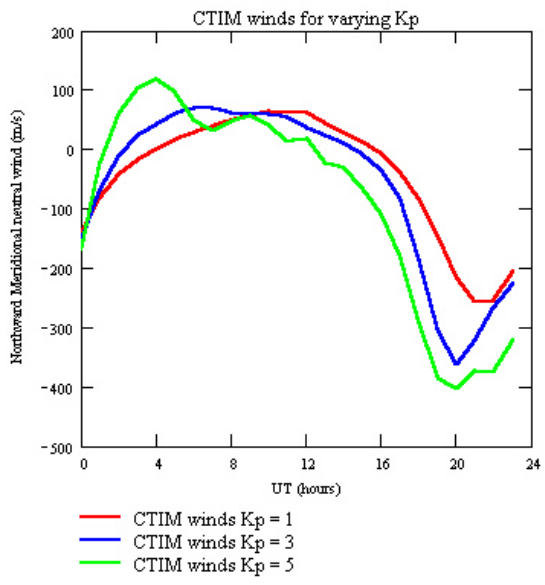
Fig. 7. A comparison showing the CTIM diurnal wind pattern for different steady state K p levels is shown. The red line corresponds to the K p = 1 conditions, the green line to K p = 3 conditions and the blue line to K p = 5